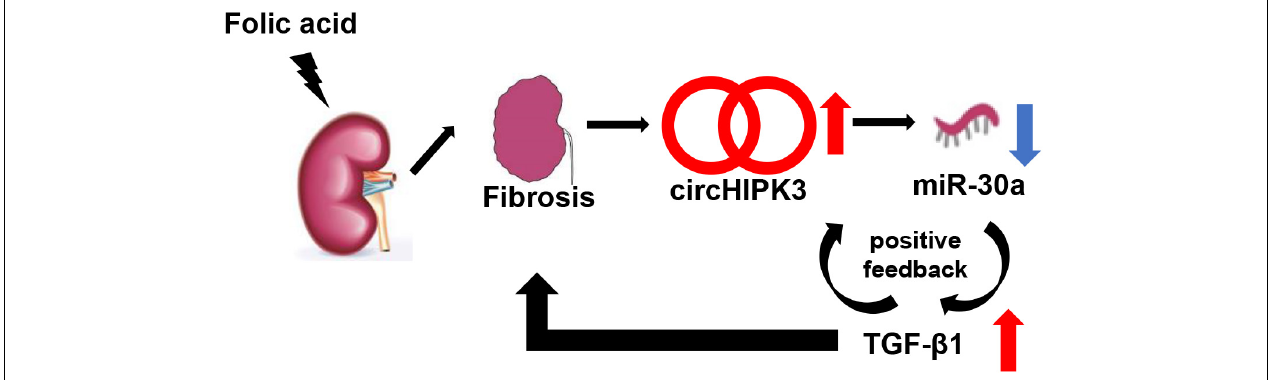
FIGURE 6 | Schematic mechanism model of the role of circHIPK3. In FA-induced renal tubulointerstitial fibrosis, circHIPK3 is increased, miR-30a is decreased, and TGF- β 1 is upregulated. A TGF- β 1 feed-forward loop exacerbates the development of renal